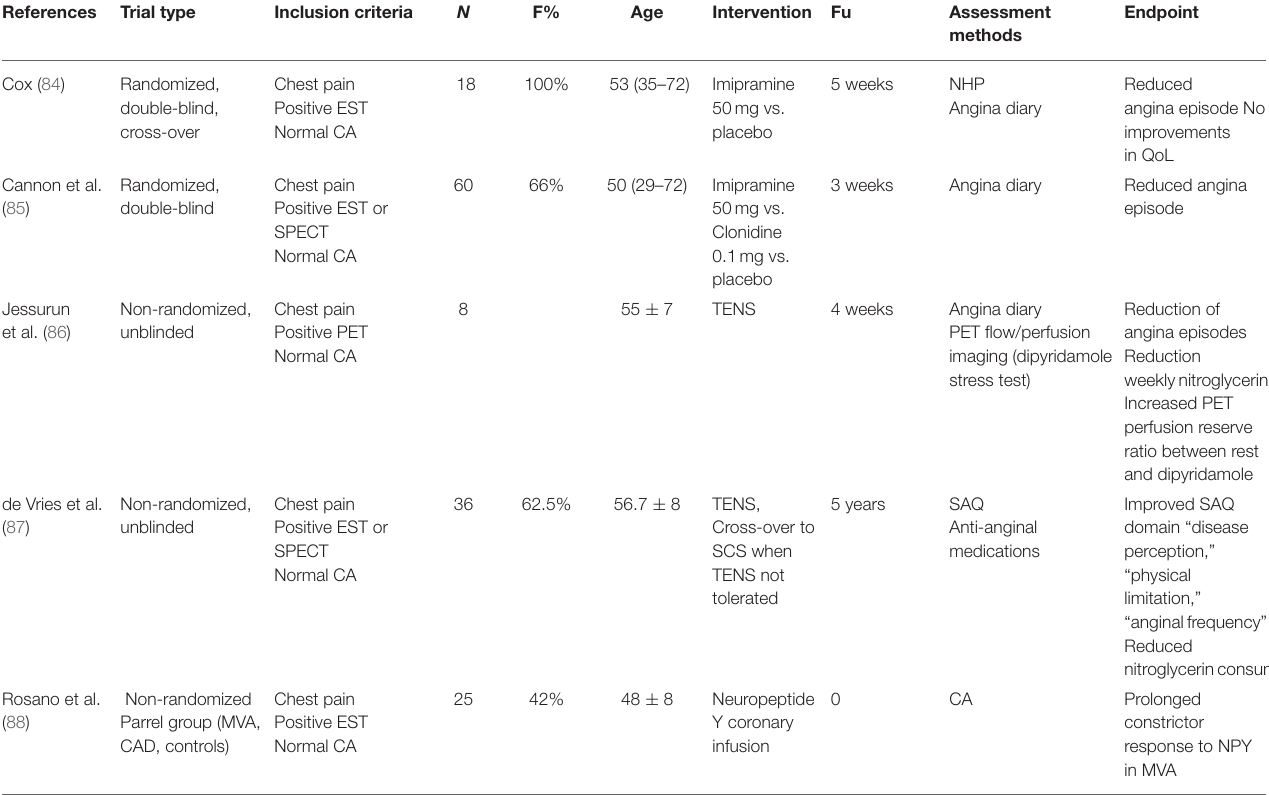
TABLE 2 | Interventional studies investigating intervention on the central nervous system in